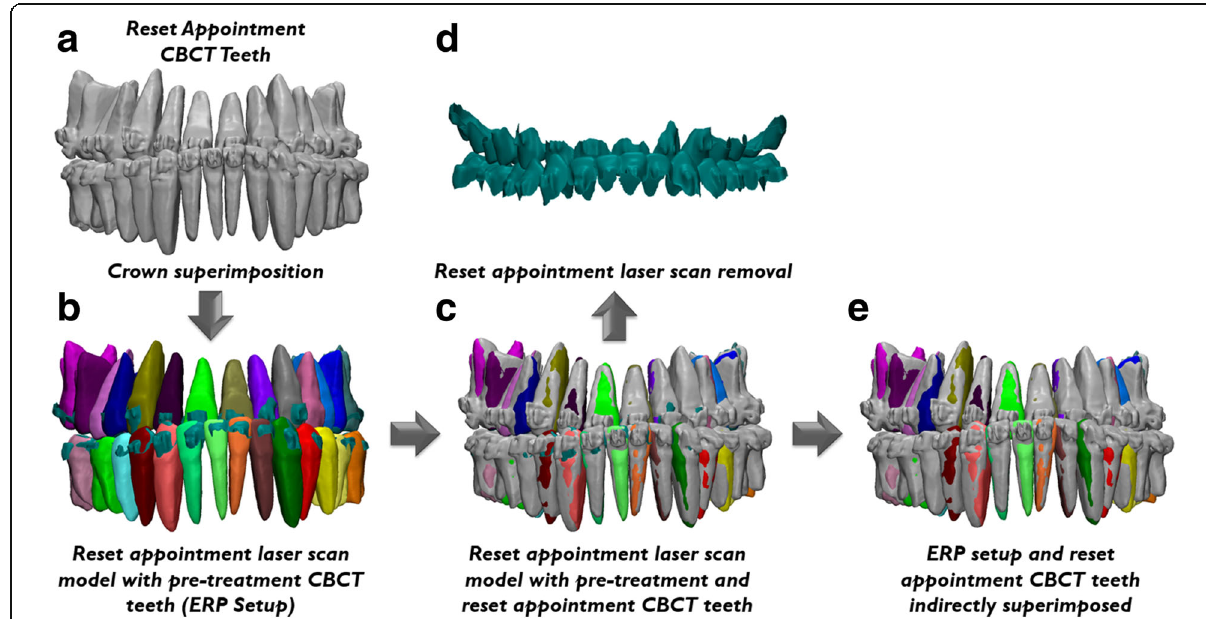
Fig. 3 Indirect superimposition process: a reset appointment CBCT teeth; b reset appointment laser scan model with superimposed pre-treatment CBCT scan yielding the ERP setup; c reset appointment laser scan with both the superimposed pre-treatment and reset appointment CBCT teeth; d removal of the laser scan model from the viewport; e remaining ERP setup and reset appointment CBCT teeth indirectly superimposed allowing for comparison of the expected and true root